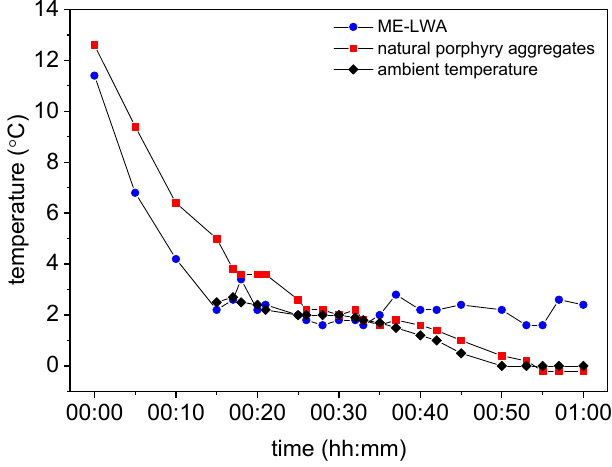
Figure 14. ( a ) Temperature differences versus time and ( b ) thermal images of natural porphyry aggregate and ME-LWAs over a period of 50 minutes.